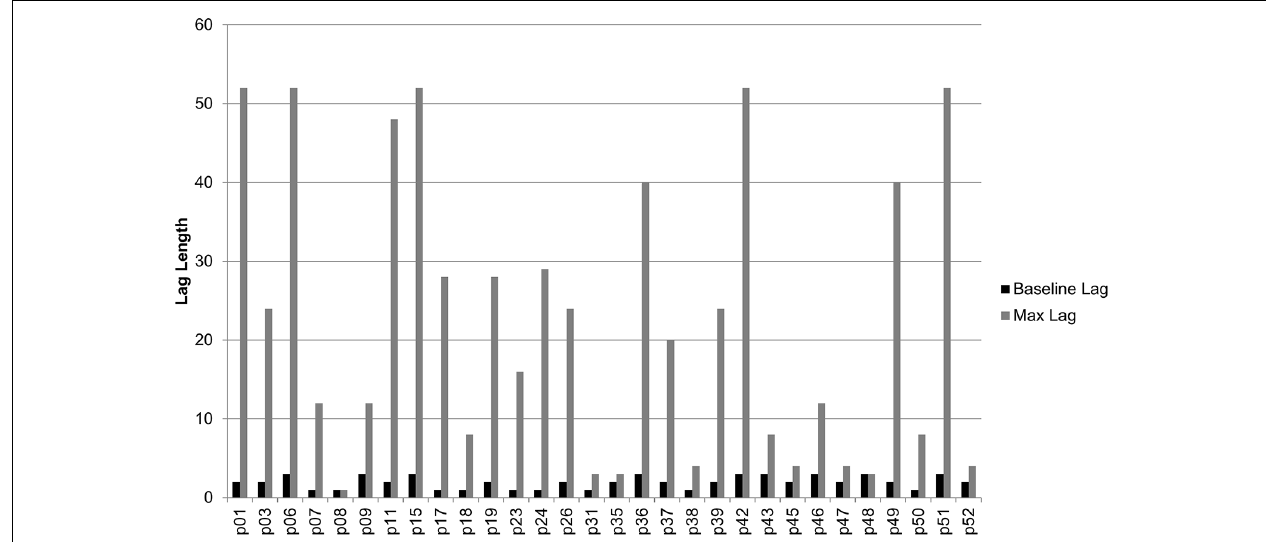
FIGURE 3 | Baseline vs. maximum lag reached by each participant in the recollection training